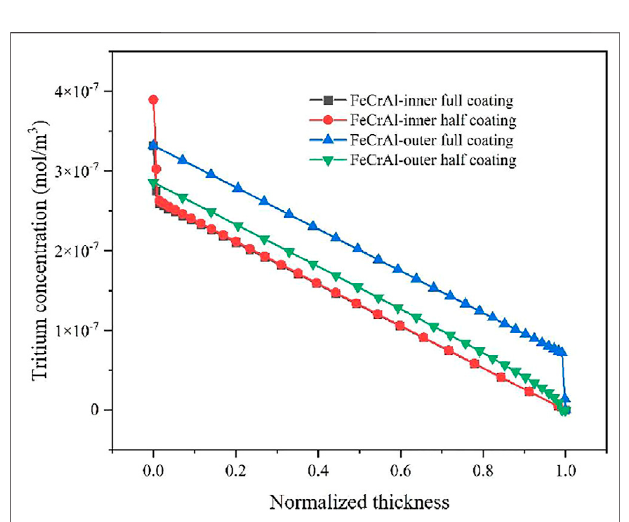
FIGURE 13 | Radial tritium concentration distribution at t = 10,000 s.